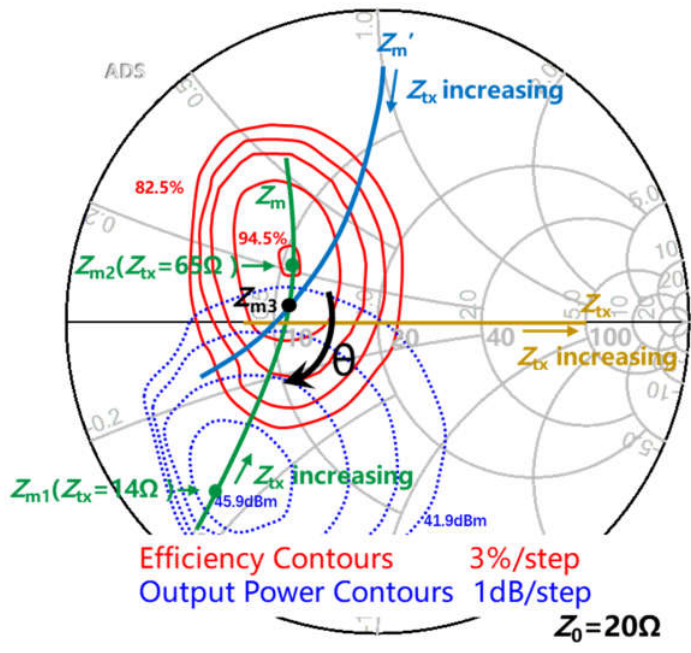
Figure 6. Efficiency and output power contours of Class-E PA.